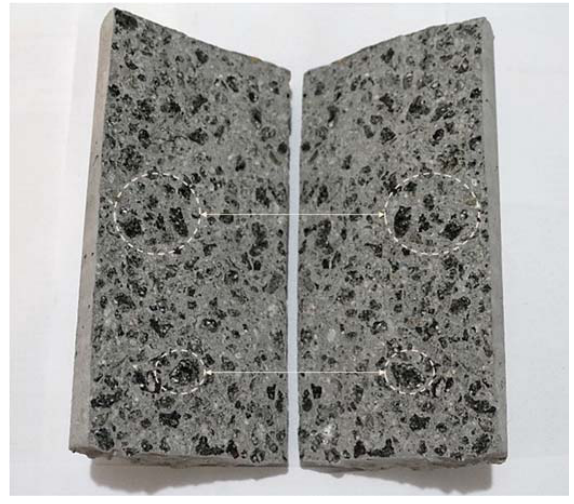
Figure 16. Splitting tensile failure.